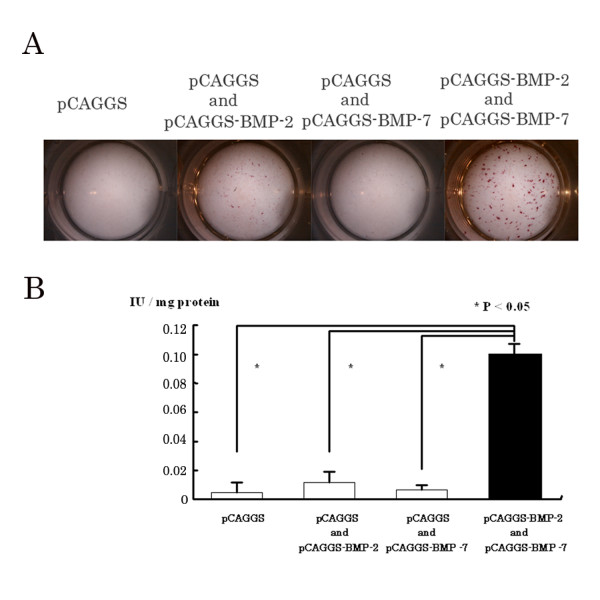
Simultaneous gene transfer with BMP-2 and BMP-7 in vitro. ALP activity in C2C12 cells transfected with pCAGGS, pCAGGS and pCAGGS-BMP-2, pCAGGS and pCAGGS-BMP-7, or pCAGGS-BMP-2 and pCAGGS-BMP-7. ALP staining in the C2C12 cells 10 days after the treatment (A). There were many more ALP-positive clusters in the combined (BMP-2 and BMP-7) gene transfer group than in cultures transfected with either gene alone. Quantitative analysis of the ALP activity in C2C12 cells transfected with BMP-2, BMP-7, or the combined BMP-2 and BMP-7 genes (B). A more than five-fold increase in ALP activity was seen after gene transfer with pCAGGS-BMP-2 and pCAGGS-BMP-7 compared with pCAGGS-BMP-7 or pCAGGS-BMP-2 alone, respectively. (*P < 0.05.)